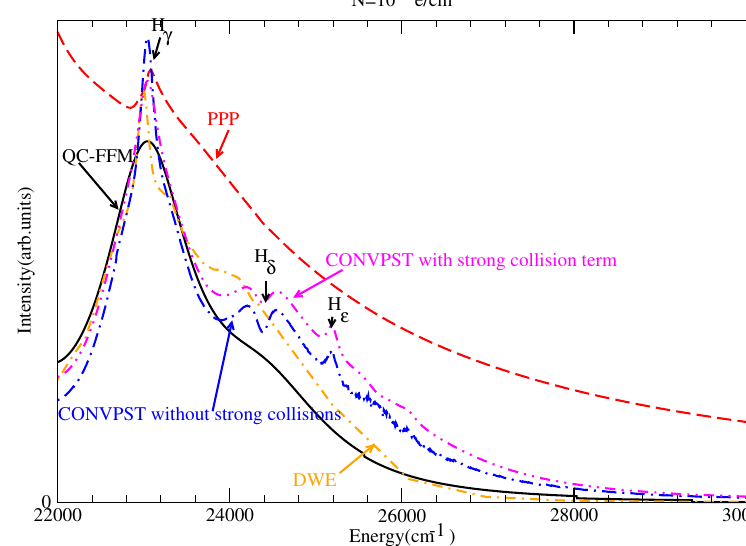
Figure 4. The series from H γ to the continuum for the intermediate density considered for DWE (dash-dotted orange) and CONVPST without (long dash-dotted blue) and with strong collisions (dash-double dotted magenta). For comparison PPP (red dashed) and QC-FFM (solid black) are also